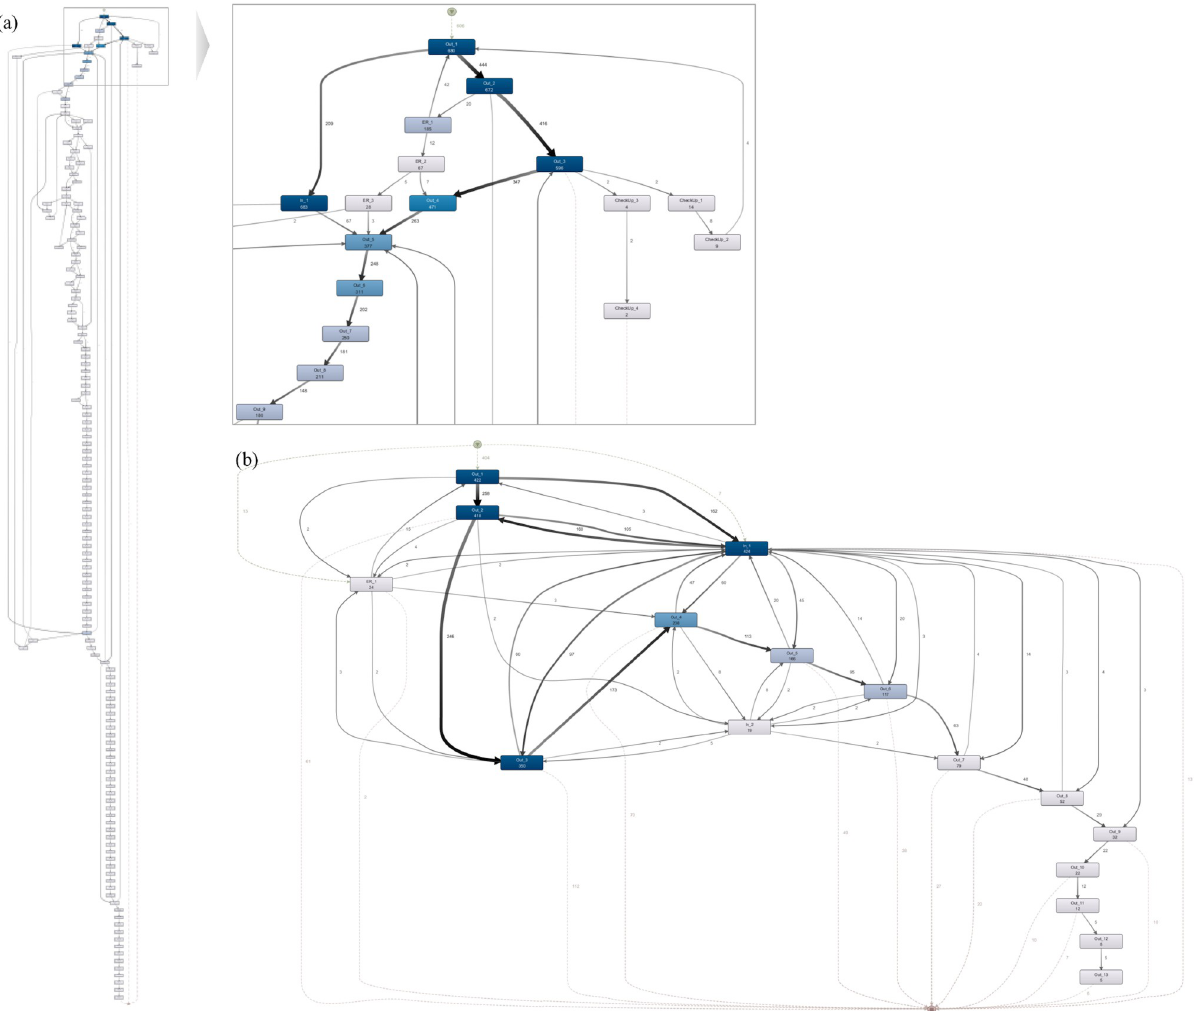
Fig 8. Patient journey map using visit-level events. (a) entire patient journey with all activities included (left) and the enlarged screenshot of the early encounters only (right); (b) patient journey with mainstream behaviors